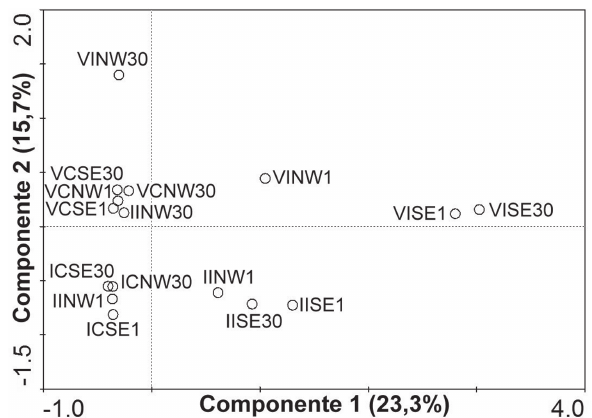
Figura 11. Resultado da análise de Correspondência da infauna nos pontos da Ilha Currais no verão (VC) e inverno (IC), e da laje submersa no verão (VI) e inverno (II) nas proximidades das ilhas Itacolomis nas faces exposta (SE) e protegida (NW); nos distanciamentos de 1 e 30